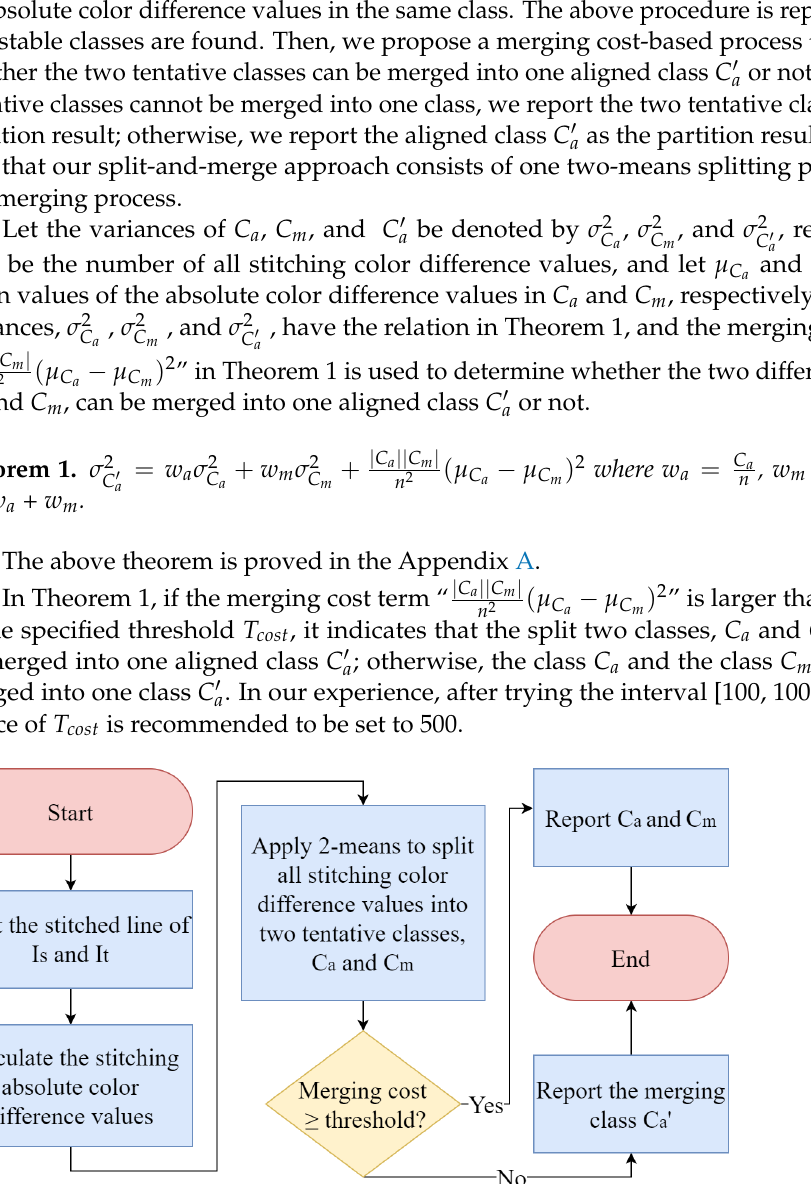
green color and the misaligned color difference pixels are marked in red